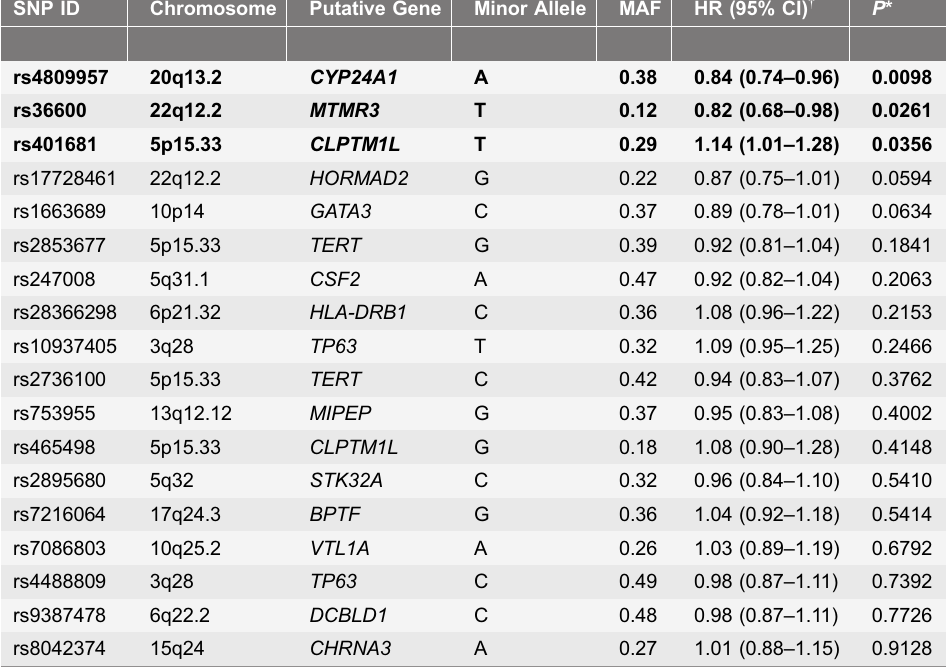
Table 2. Associations of 18 candidate SNPs and survival of patients with small-cell lung